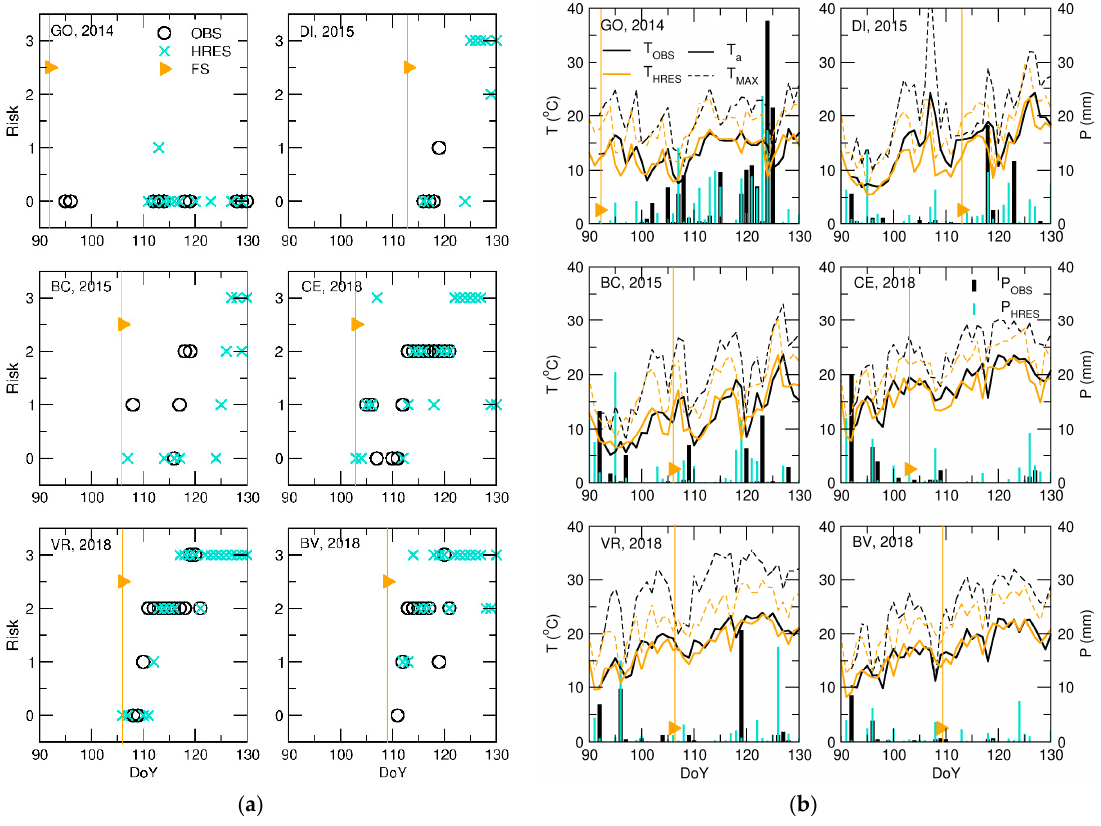
Figure 8. BAHUS-E runs with observed (OBS; o) and forecasted (HRES; x) temperature and precipitation at the time of apple flowering (start of flowering is shown with orange vertical lines and symbols) for all locations with ( a ) no risk = 0, low risk = 1, medium risk = 2, and high risk = 3; and ( b ) observed and forecasted values of average daily temperature (Ta), maximal temperature (Tmax), and precipitation (P) for the selected time period.